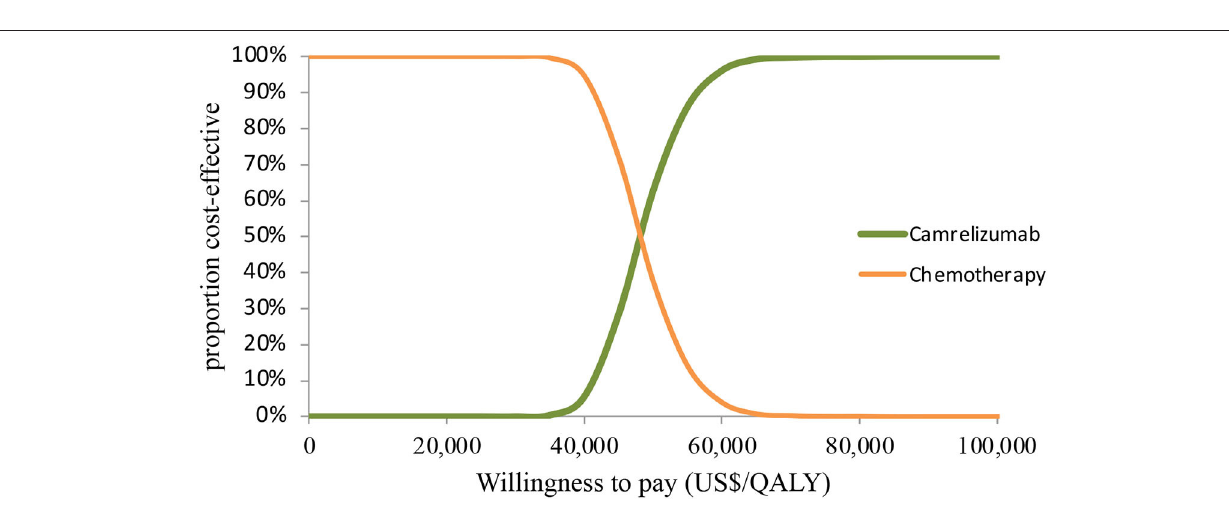
FIGURE 5 | Cost-effectiveness acceptability curve for the subgroup analysis. QALY, quality-adjusted